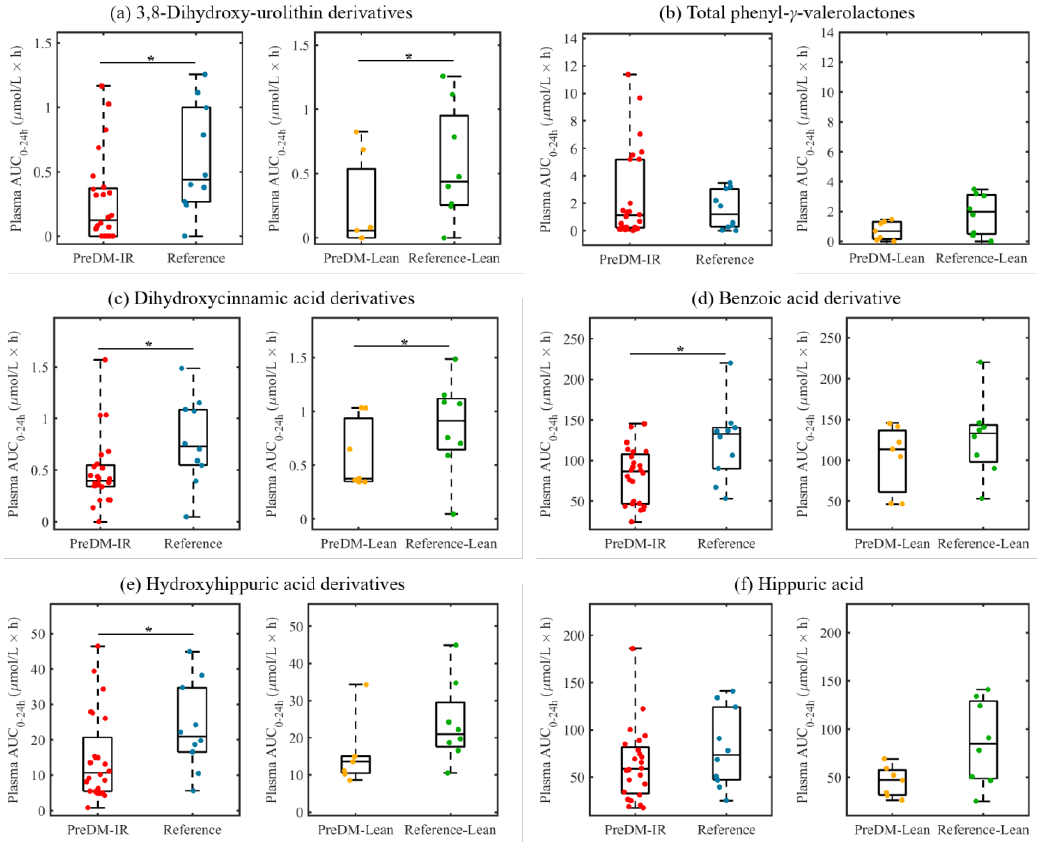
Figure 5. Box plots showing AUC 0–24 h (areas under the 24 h curve) of microbial (poly)phenolic metabolites in plasma post-consumption of the red raspberry test (RRBtest) drink in PreDM-IR (red dots) vs. Reference (blue dots) and PreDM-Lean (yellow dots) vs. Reference-Lean (green dots): ( a ) 3,8-dihydroxy-urolithin derivatives; ( b ) total phenyl- γ -valerolactones; ( c ) dihydroxycinnamic acids derivatives; ( d ) benzoic acids derivatives; ( e ) hydroxyhippuric acids derivatives; ( f ) hippuric acid. * Significantly different, p < 0.05.